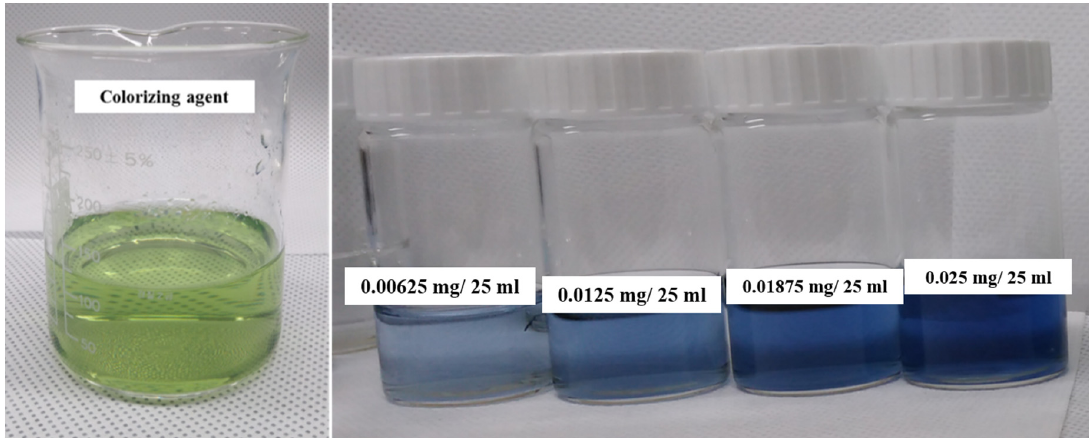
Figure 5. Images of the prepared colorizing agent and the turned blue standard solutions along with various phosphate concentrations.